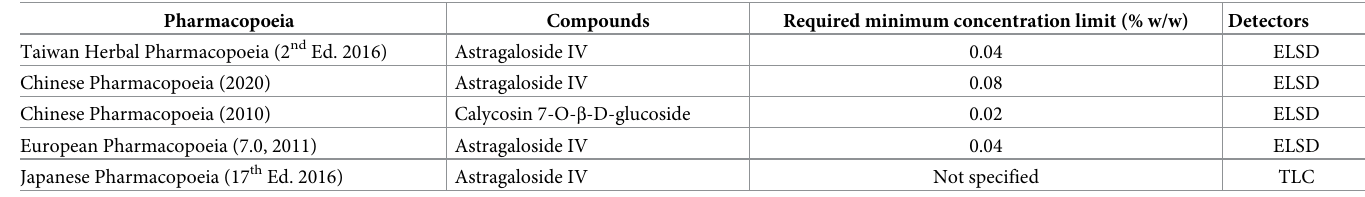
Table 2. Pharmacopeial limit of compounds to be present in